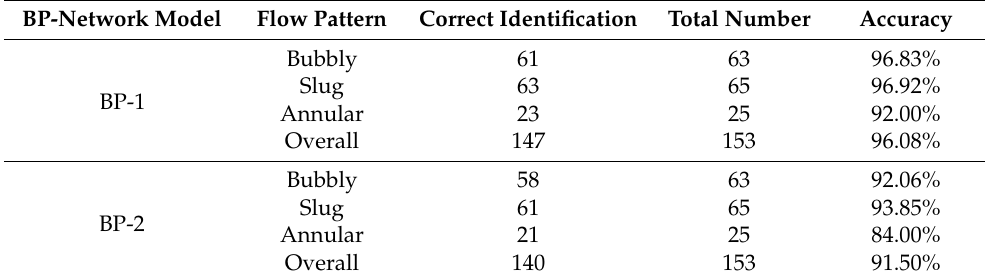
Table 9. The identification results of BP-network models.